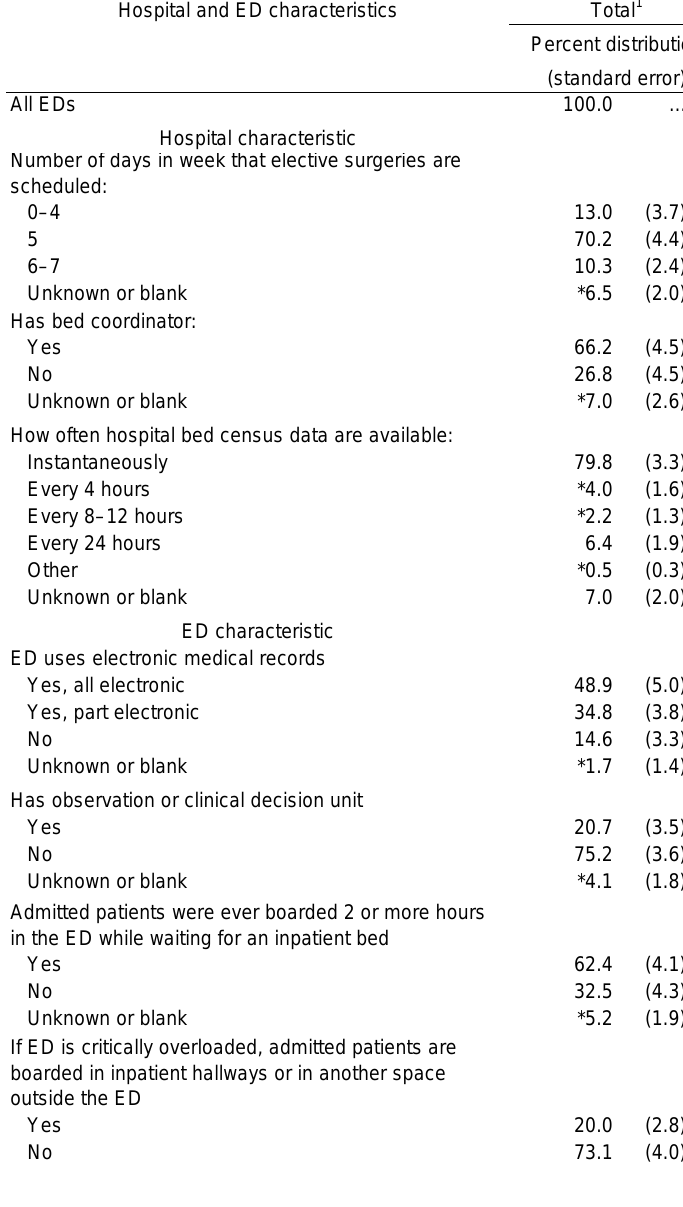
Table 27. Hospital and emergency department characteristics, by emergency department visit volume and metropolitan status: United States, 2011 Hospital and ED